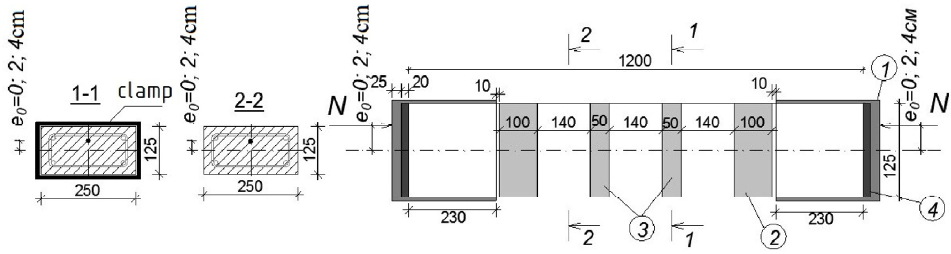
Figure 5. Structural version of the reinforcement of the columns with external transverse composite reinforcement and the load application scheme: 1—steel head, 2 and 3—end stirrup-anchor and